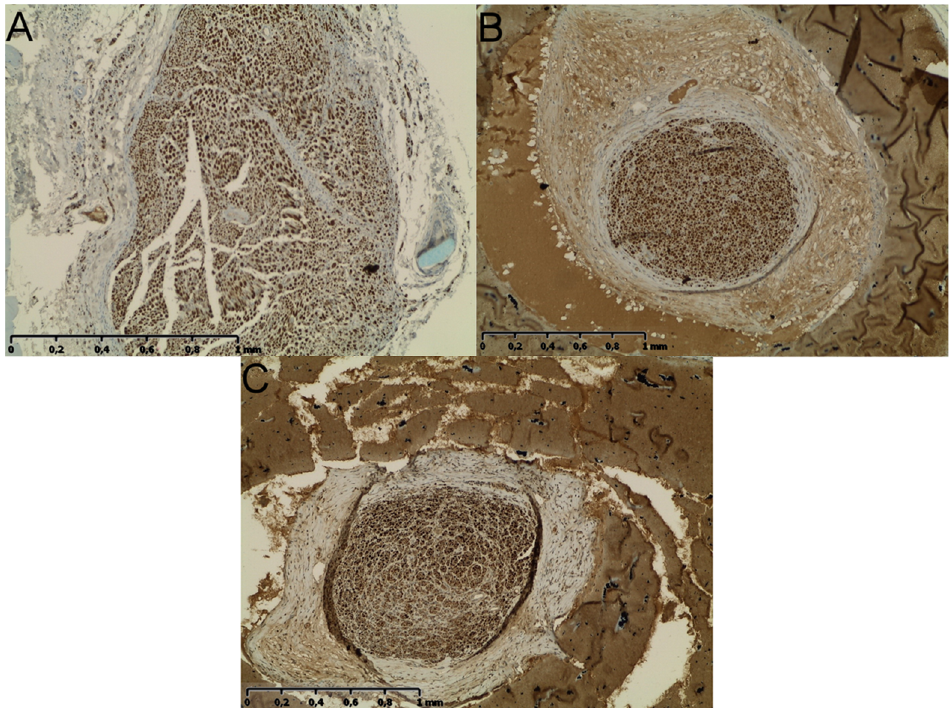
Figure 9. NF-200 immunohistochemistry images of nerve sections in the center of conduit/autograft. ( A ) Autograft group, gentle inclusion of fibrotic tissue with the graft was noted, a high number of well-developed nerve fibers were present with medium-sized myelin sheaths, regular morphology of perineurium. ( B ) P(LLA-CL)-COL-PANI conduit group—fibers are densely encapsulated within the lumen of the conduit, the perineurium is significantly developed and often exceeds 50% of the area of the conduit lumen, yet without signs of fibrosis, scarring, or compression within nerve fiber tissues. The outer layer consists of a partially dissolved conduit ( C ) P(LLA-CL)-COL-PANI conduit with the ASC group—the density of nerve fiber within the epineurium sheath is high, without scarring of fibrosis. The perineurium is thick, but to a lesser extent vs. conduit alone, it does not fully fill the lumen of a conduit. The outer layer consists of a partially dissolved conduit. Scale bar 1 mm.